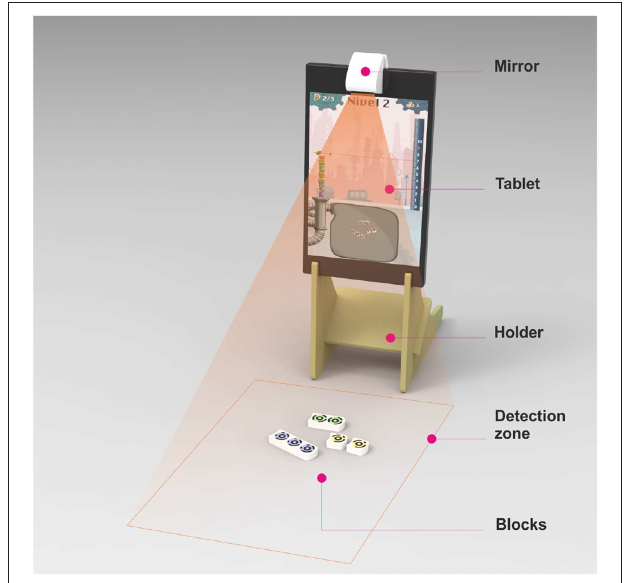
FIGURE 3 | Tangible setting for BrUNO. Figure reproduced with author’s permission (Marichal et al.,